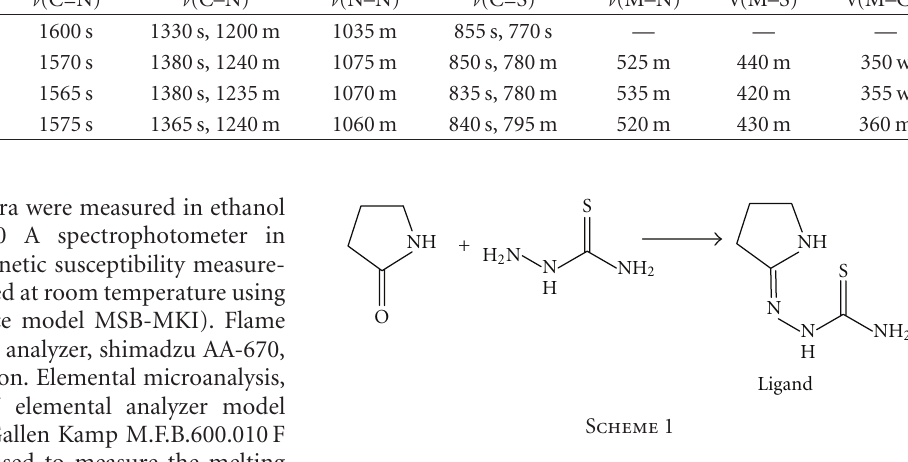
Table 2: Infrared absorption frequencies (cm − 1 ) of Co(II), Ni(II), and Cu(II) complexes.